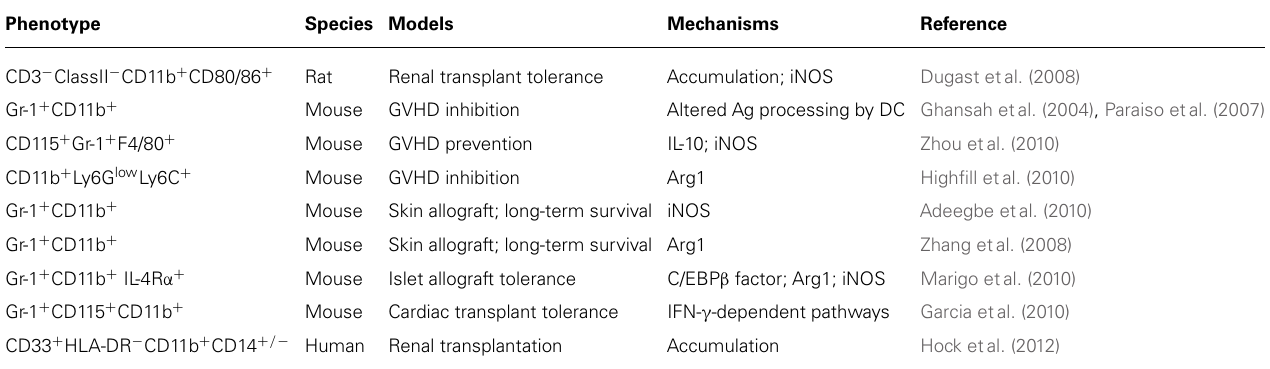
Table 1 | Reported involvement of MDSC in